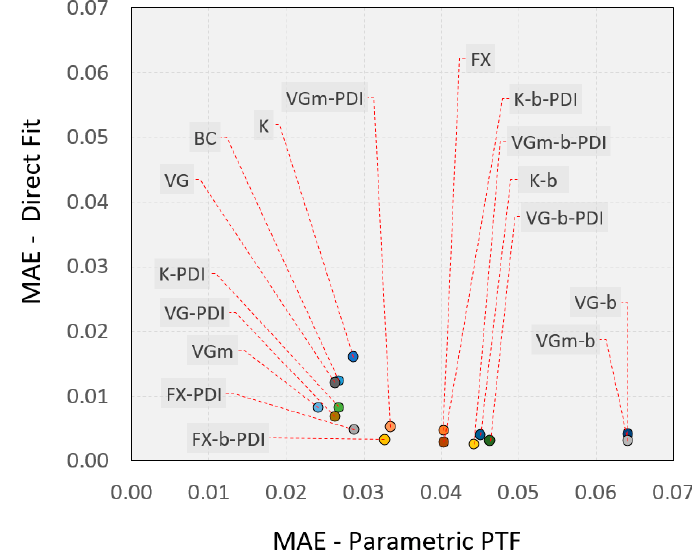
Figure 6. Mean absolute error (MAE) values for all 16 models with the fitted versus the PTF-estimated parameters (scenario 6). 1 BC: Brooks and Corey [34], FX: Fredlund and Xing [35], K: Kosugi [36],